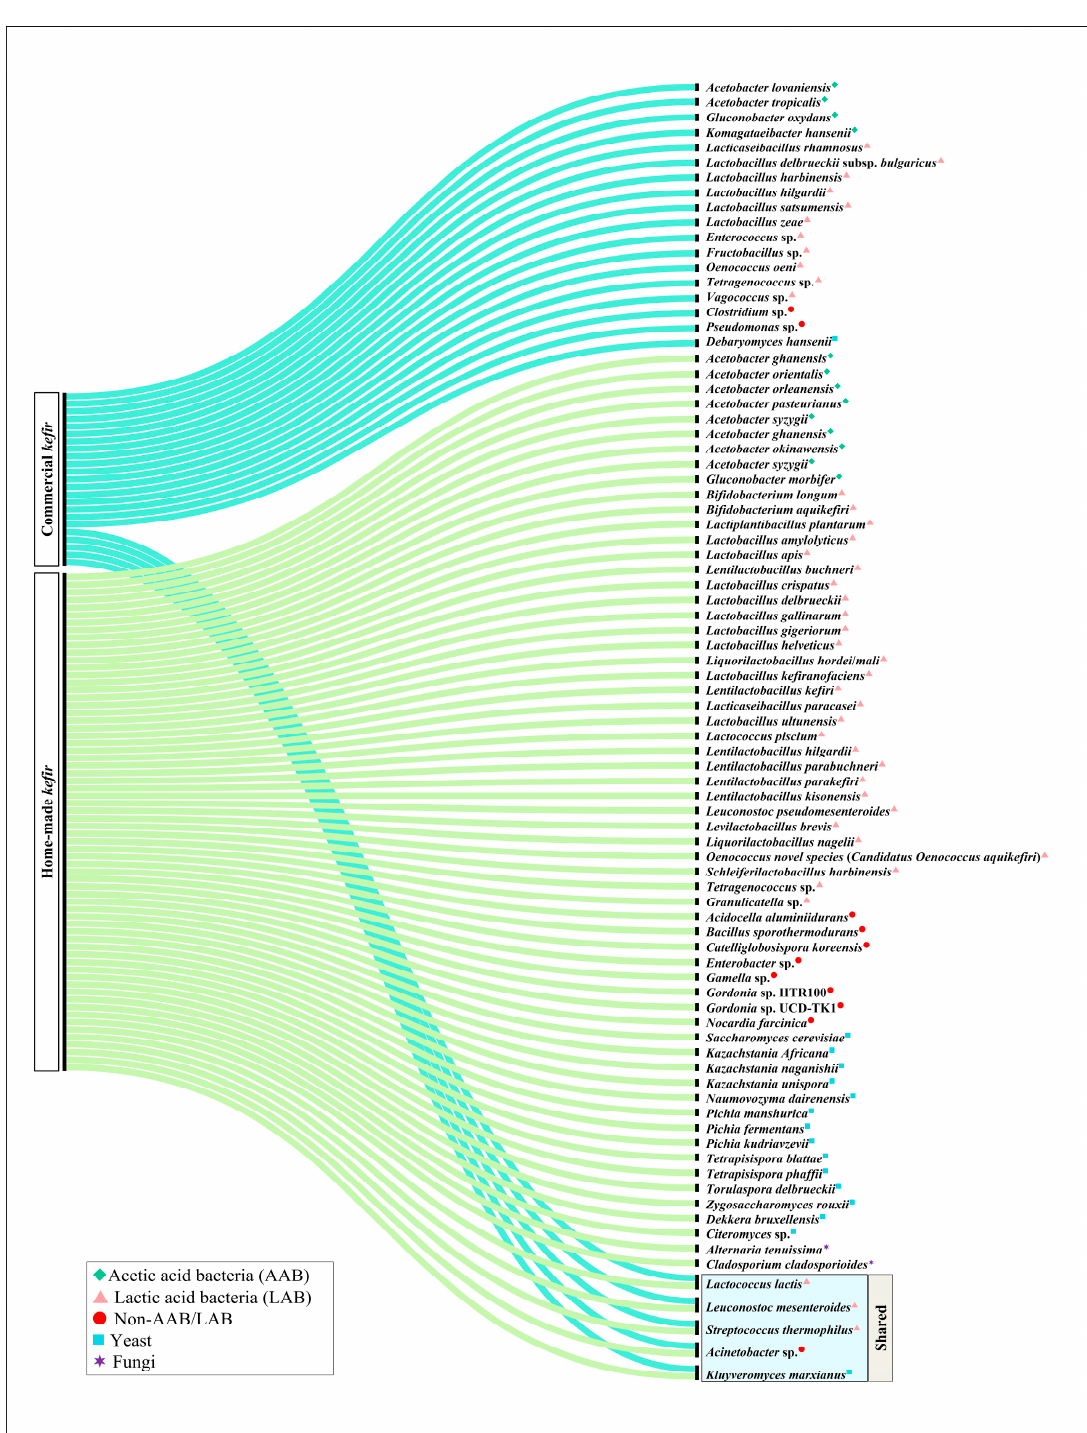
Figure 2. A Sankey diagram represented the total microbiota reported from both commercial and home-made kefir as reported through metagenomics studies. A total of 23 genus/species have been reported from commercial varieties, whereas about 66 have been reported form home-made kefir, which consists of lactic-acid bacteria (LAB), acetic-acid bacteria (AAB), non-AAB/LAB, yeasts, and fungi. Bacillota -associated lactic-acid bacterial species viz ., Lactococcus lactis , Leuconostoc mesenteroides , and Streptococcus thermophilus ; Pseudomonadota- associated species, Acinetobacter sp., and yeast- Kluyveromyces marxianus are the five most commonly shared microbes reported from the two varieties of kefir